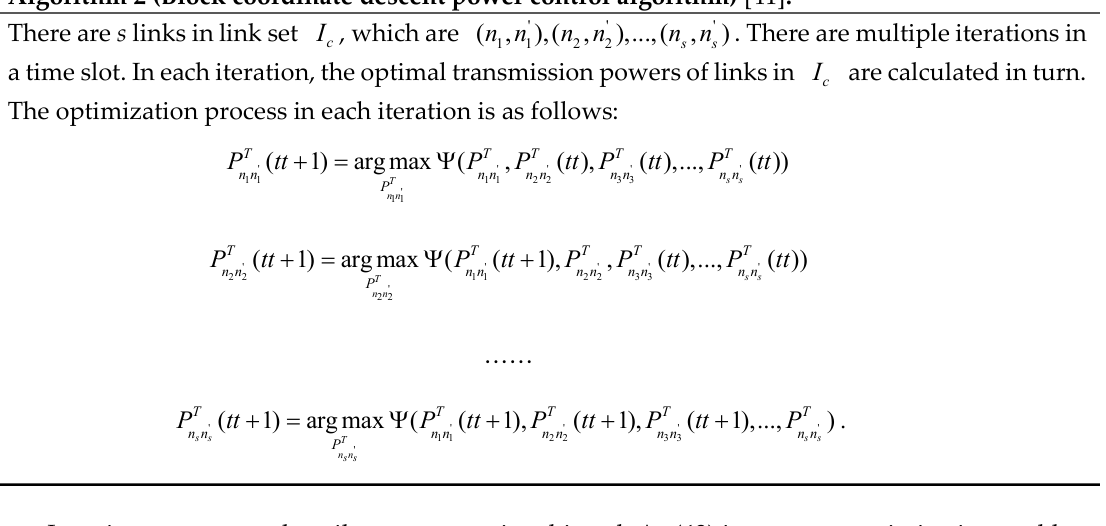
Algorithm 2 (Block coordinate descent power control algorithm) [41]